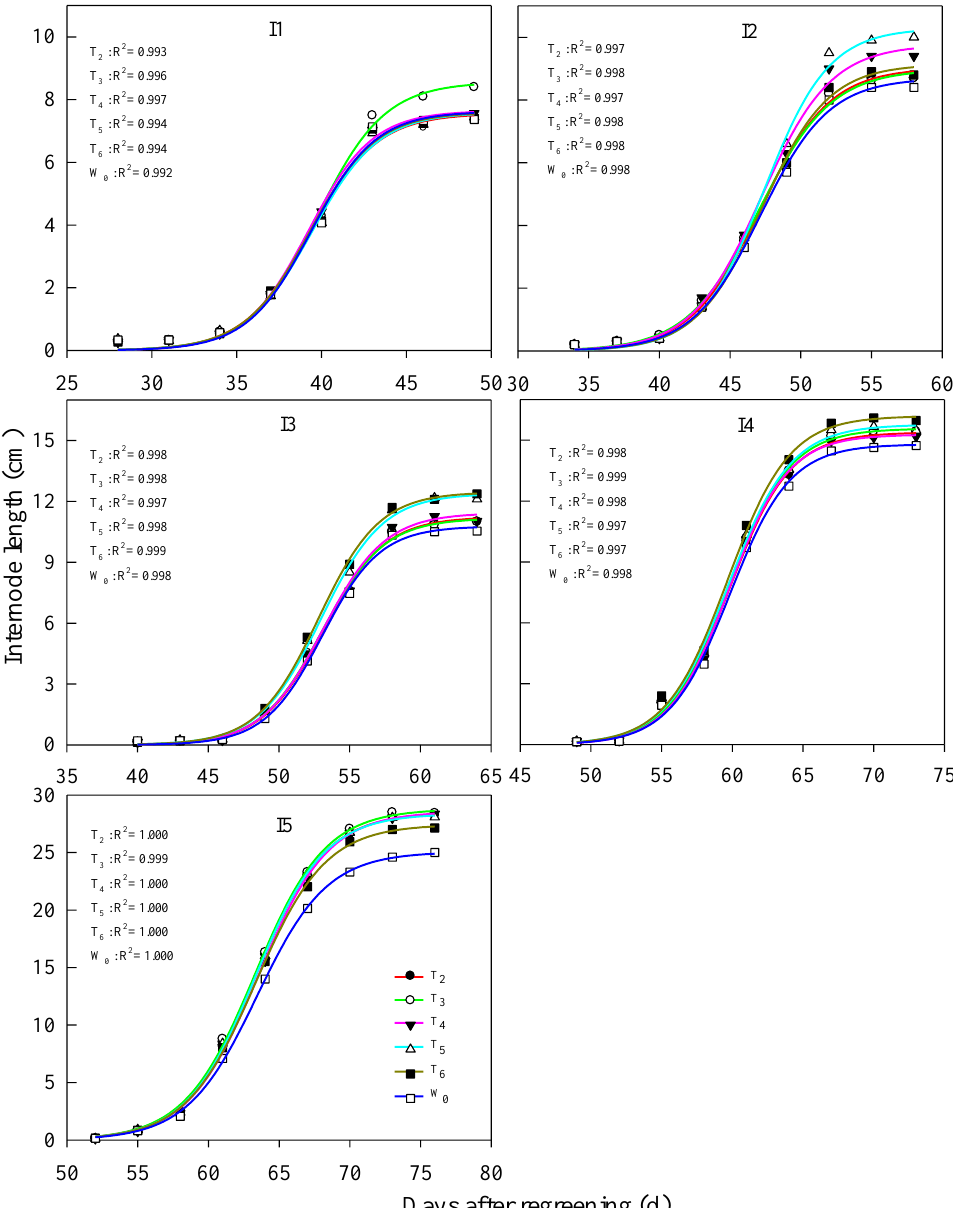
Figure 7. Growth process of each internode in the growing season from 2020 to 2021. I1–I5 represent the first internode to the fifth internode in springtime.